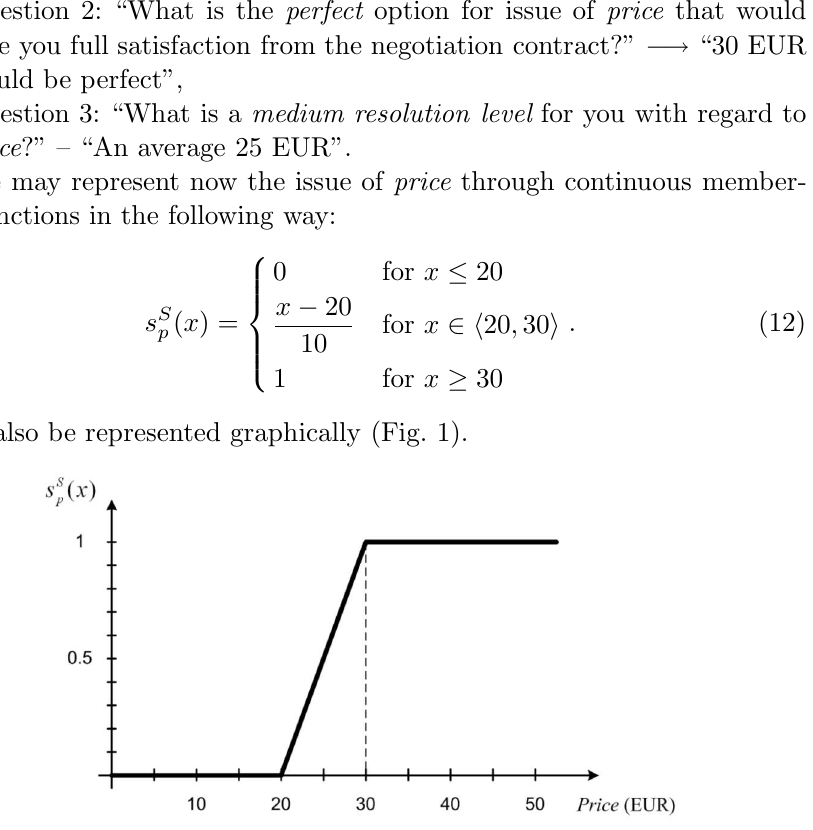
Figure 1. The Sellers membership function for